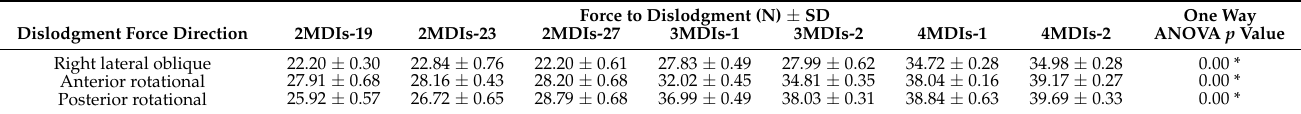
Table 1. The initial mean ± standard deviation of force to dislodgement in three directions, * p < 0.05. Force to Dislodgment (N) ±